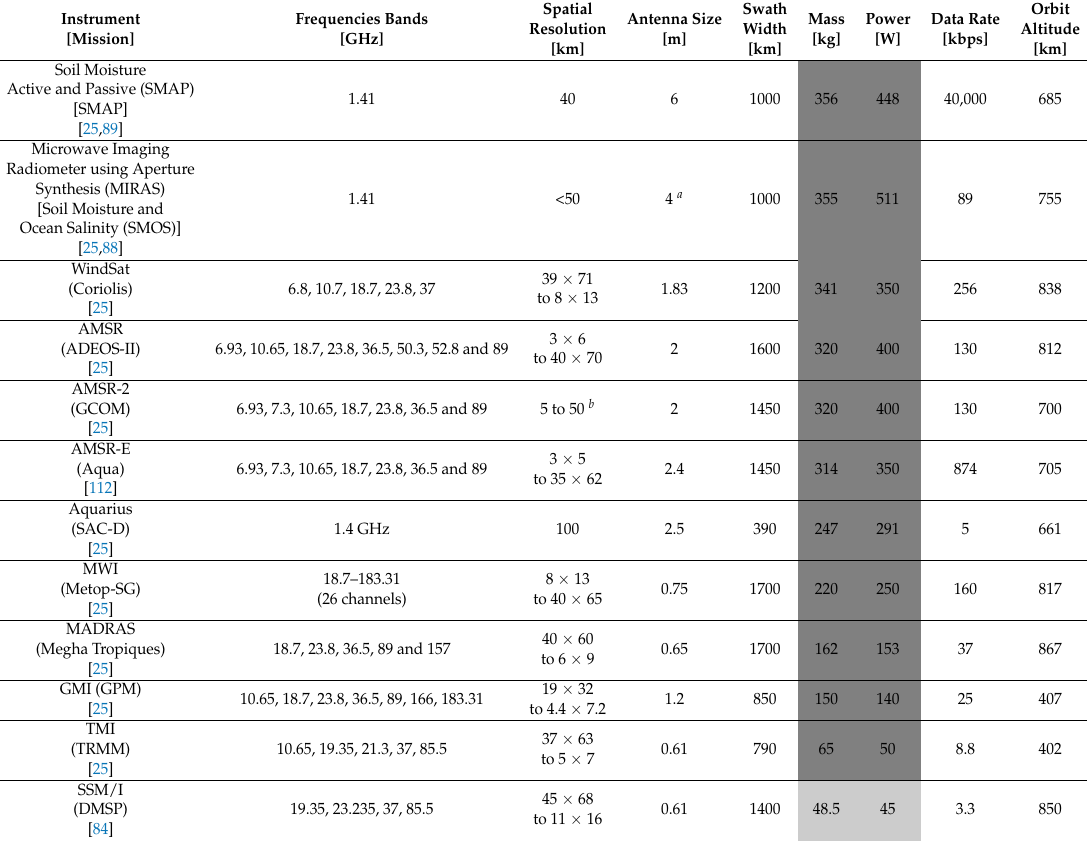
Table A4. Survey of microwave imagers (MWI).